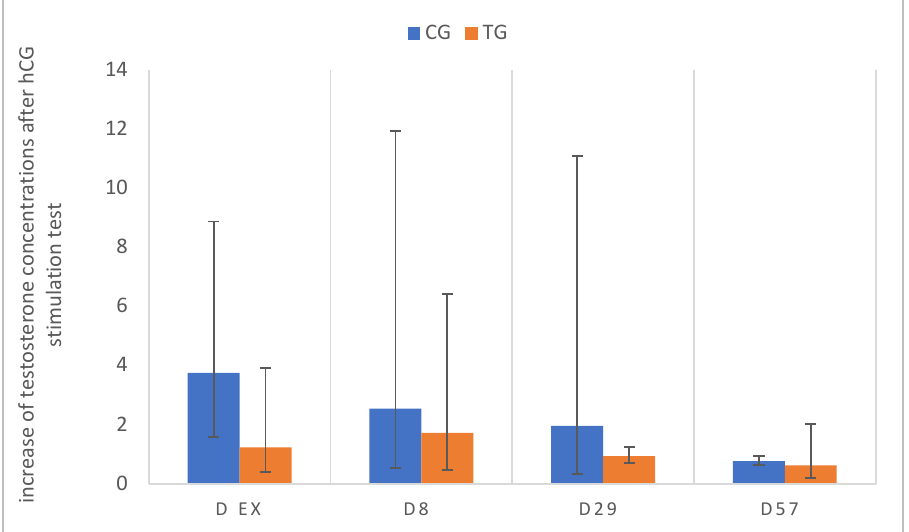
Figure 11. Relative increase in plasma testosterone concentrations 60 min after hCG stimulation; pre-stimulation testosterone values are considered as 1, relative increase from pre- to post-stimulation is presented for study day D ex, D8, D29, D57 animals treated with a 4.7 mg deslorelin implant (TG, n = 6) and saline-treated control animals (CG, n = 3). Results are given as geometric mean x ̅ g (DF).